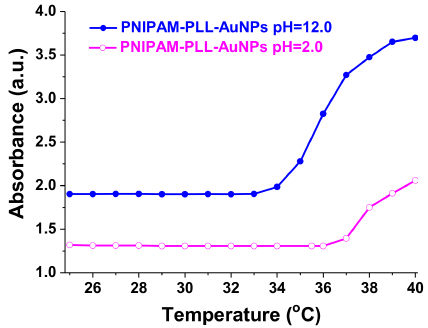
Figure 10. Variation of absorbance PNIPAM-PLL-AuNPs at λ max as a function of temperature under two pH conditions (pH = 2.0 and 12.0) (Concentration: 2.0